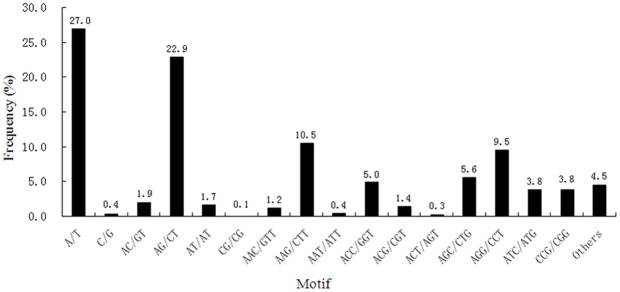
Frequency distribution of SSRs based on motif sequence types.